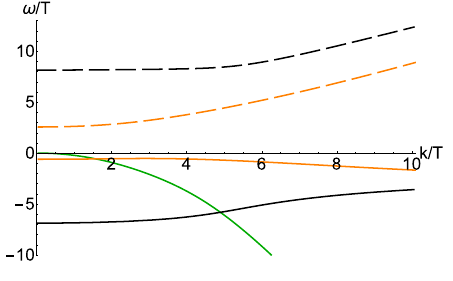
Figure 6 . The lowest CM in a (cid:22)=T (cid:25) 5 RN background. The dashed line is the real part of !=T , while the solid lines are the imagi- nary parts. The real part of the green mode coincides with the horizontal axis. The black mode originates from the (gravitational) sound mode, the green from the lowest EM mode.